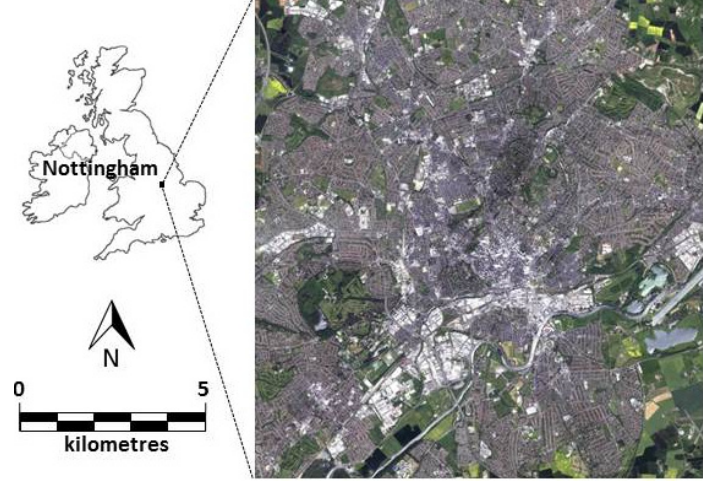
Figure 1. Nottingham, UK study area location and WorldView-2 image (© DigitalGlobe, Inc. All Rights Reserved). Table 1. Nottingham urban land cover classification schema.